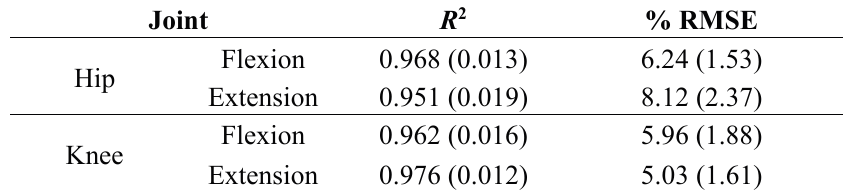
Table 6. Average R 2 and normalized RMS errors between (cid:2254)(cid:3548) (cid:3014)(cid:3010)(cid:3020)(cid:3016) and (cid:2254)(cid:3548) (cid:3014)(cid:3006)(cid:3014)(cid:3008),(cid:3010)(cid:3020)(cid:3016) during isometric contraction. Standard deviations are presented in